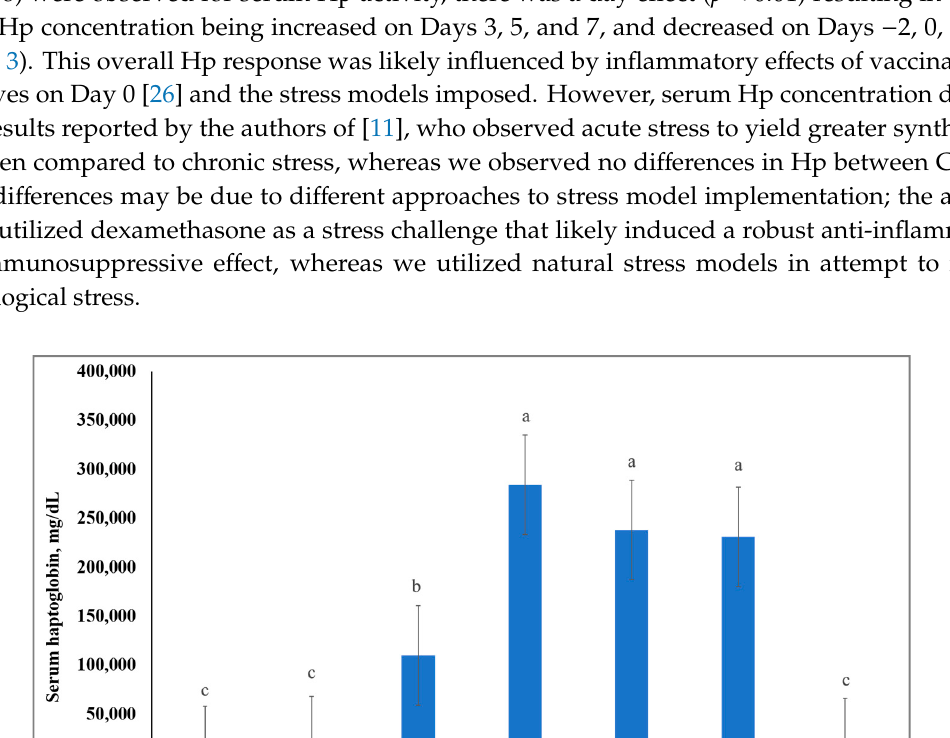
p < 0.01). Across day, unlike superscript letters indicate a difference ( p ≤ 0.01) in means.